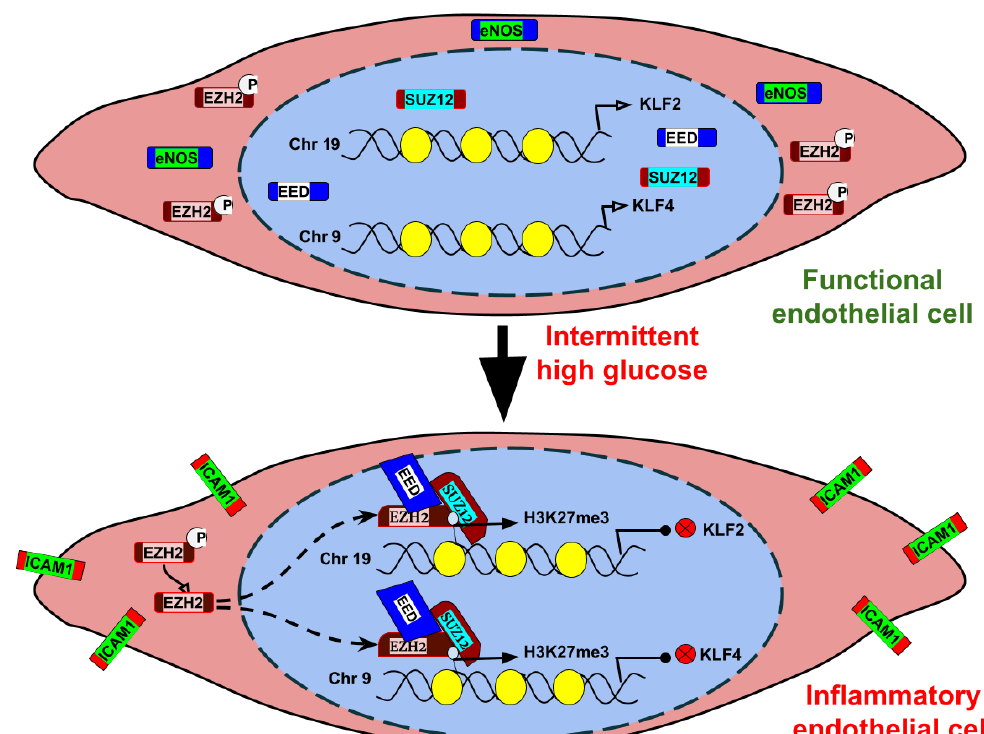
Figure 7. Mechanism by which elevated H3K27me3 level upon intermittent high glucose exposure promotes inflammatory signaling in endothelial cells. In normal human endothelial cells, the histone methyltransferase EZH2 localizes primarily in cytosol and thus causes restricted tri-methylation of lysine residue 27 (K27) on histone H3 (H3K27me3). During such condition, the expression levels of essential signaling molecules such as KLF2, KLF4, and eNOS are maintained in endothelial cells to allow physiological function. In human endothelial cells exposed to intermittent hyperglycemia, this causes nuclear localization of EZH2 by de-phosphorylating Thr367 phosphorylation. Once localized in the nucleus, it assembles PRC2 and binds to histone H3 to cause an elevated quantity of H3K27me3. Such gain of H3K27me3 upon intermittent hyperglycemic exposure results in repression of KLF2 and KLF4 through promoter-level enrichment of H3K27me3. Repression of KLF2 and KLF4 initiates inflammatory signaling in endothelial cells through downregulation of eNOS and upregulation of ICAM1.